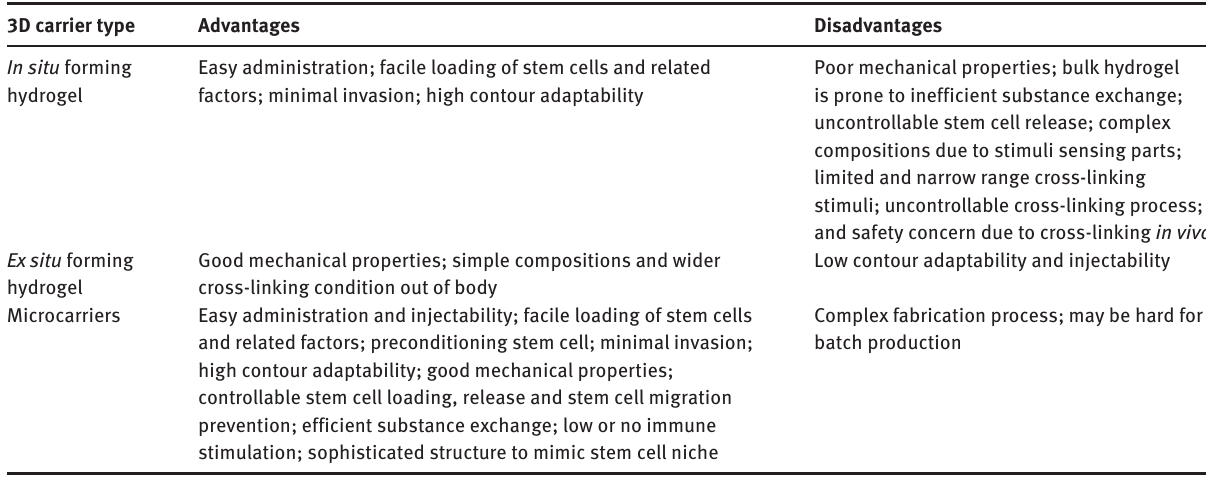
Table 1: The comparison of hydrogel based 3D carriers. 3D carrier